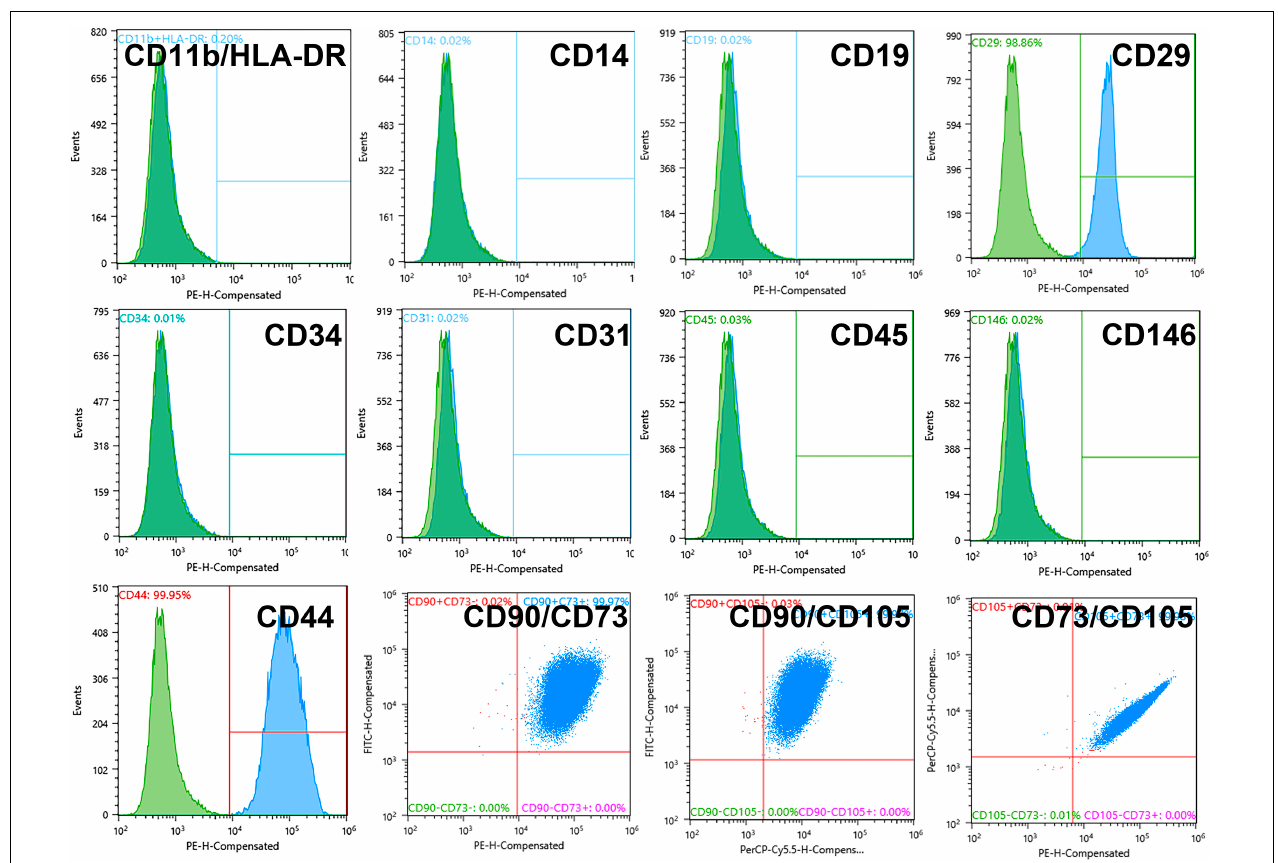
FIGURE 1 | Adipose-derived stromal cell (ADSC) 2D culture showed a standard multipotent mesenchymal stromal cell (MMSC) phenotype at Passage 4 (before 3D cultivation). Negative marker levels: 0.02% of CD11b/HLA-DR cells, 0.02% of CD14 cells 0.02% of CD19 cells, 0.03% of CD45 cells, 0.01% of CD34 cells, 0.02% of CD31 cells, 0.02% of CD146 cells; positive marker levels: 98.86% of CD29 cells, 99.95% of CD44 cells, 91.94% of CD90 cells, 98.15% of CD105 cells, 99.99% of CD73 cells. The blue-filled histograms indicate the positively stained cells, while the green-filled histograms indicate the isotype-matched antibody controls. Flow